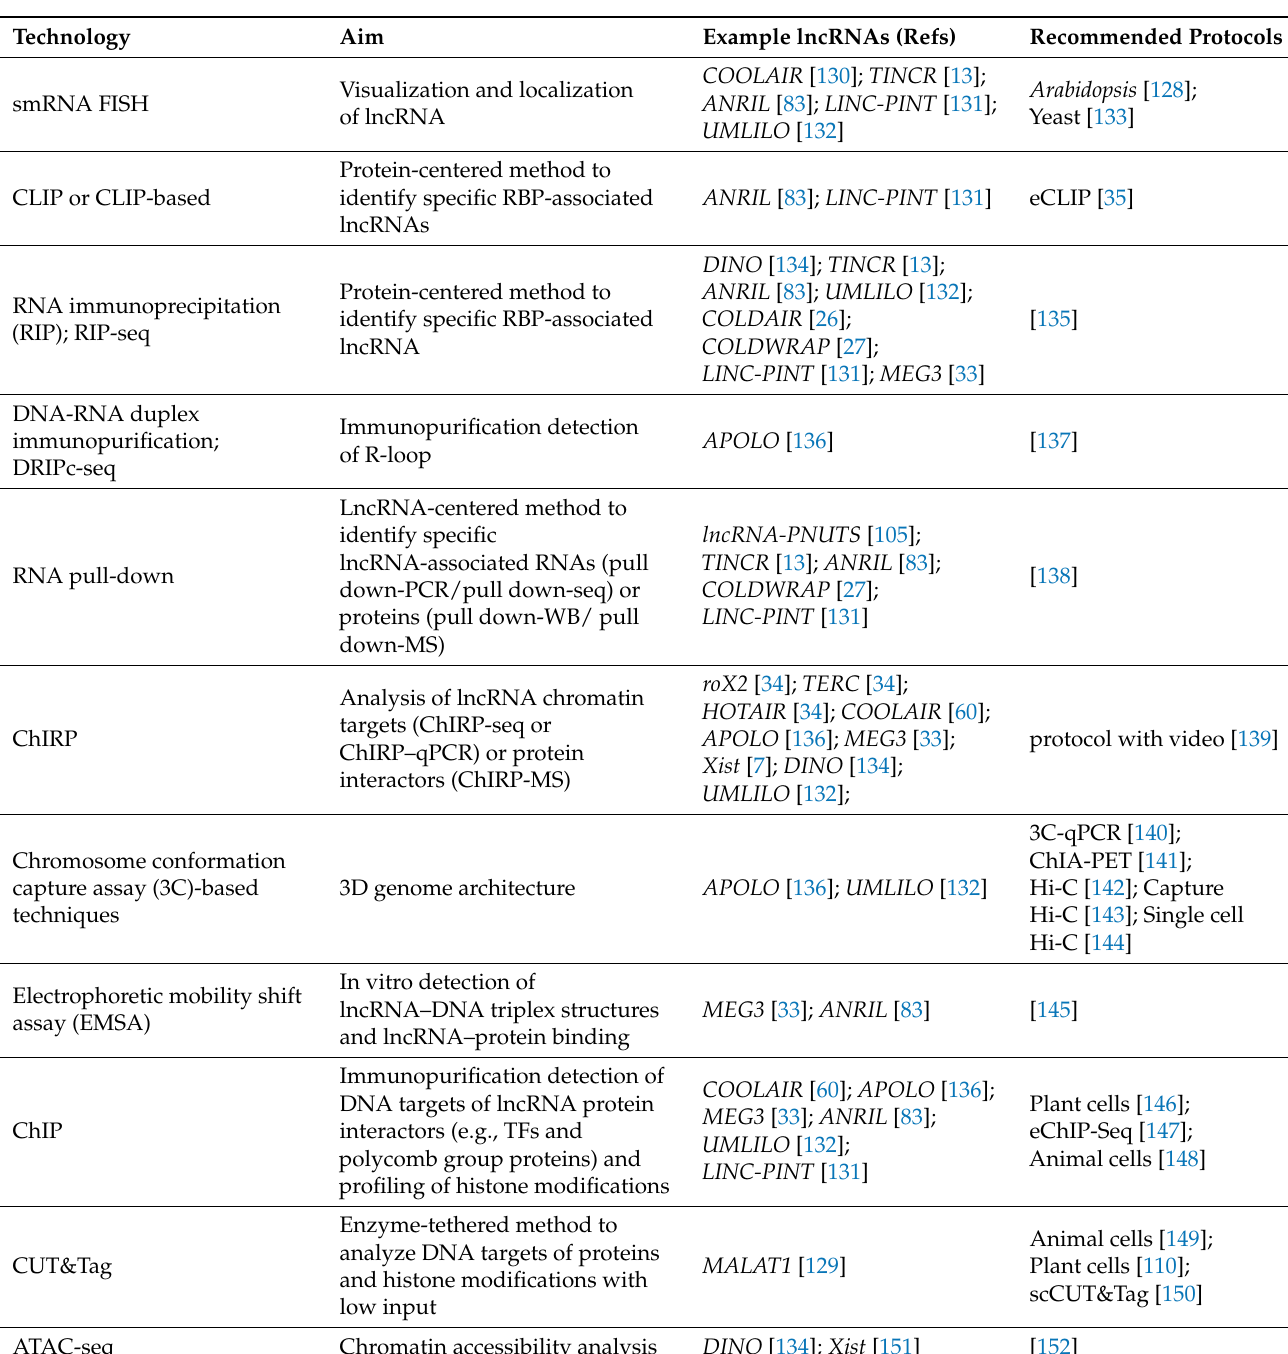
Table 3. Application of methodologies in specific lncRNA